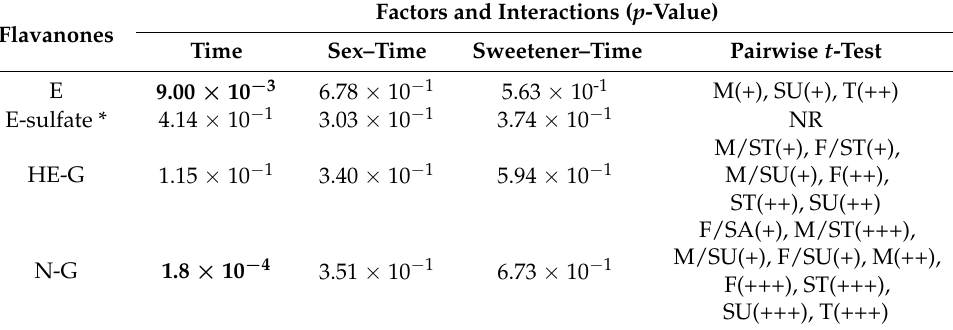
Table 2. p -value for the ANOVA and pairwise t-test analysis of flavanones results. In bold, those p -values < 0.05 from ANOVA. In the t -test results, (+) means a positive relation. More than one symbol indicates a higher grade of relation, based on a p -value < 0.01 for (++) and p -value < 0.001 for (+++). Abbreviations: M, male; F, female; SU, sucrose, ST, stevia; NR, non-relevant.